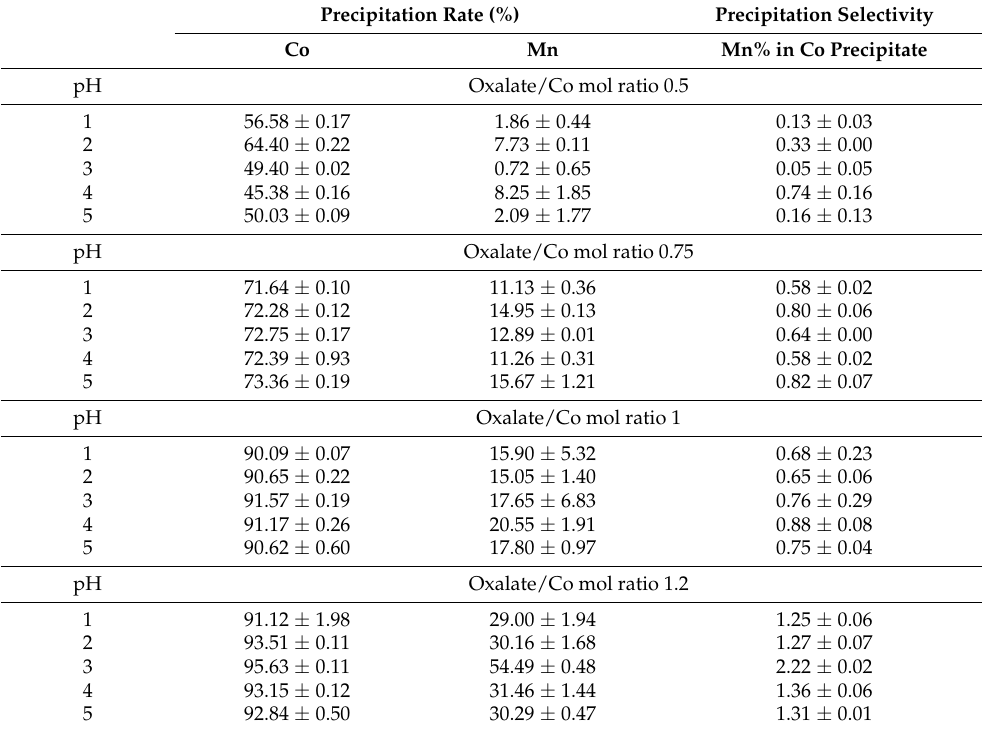
Table 7. The precipitation rate and selectivity of Co and Mn using oxalic acid based on mol ratio of Oxalate/Co and initial pH of strip